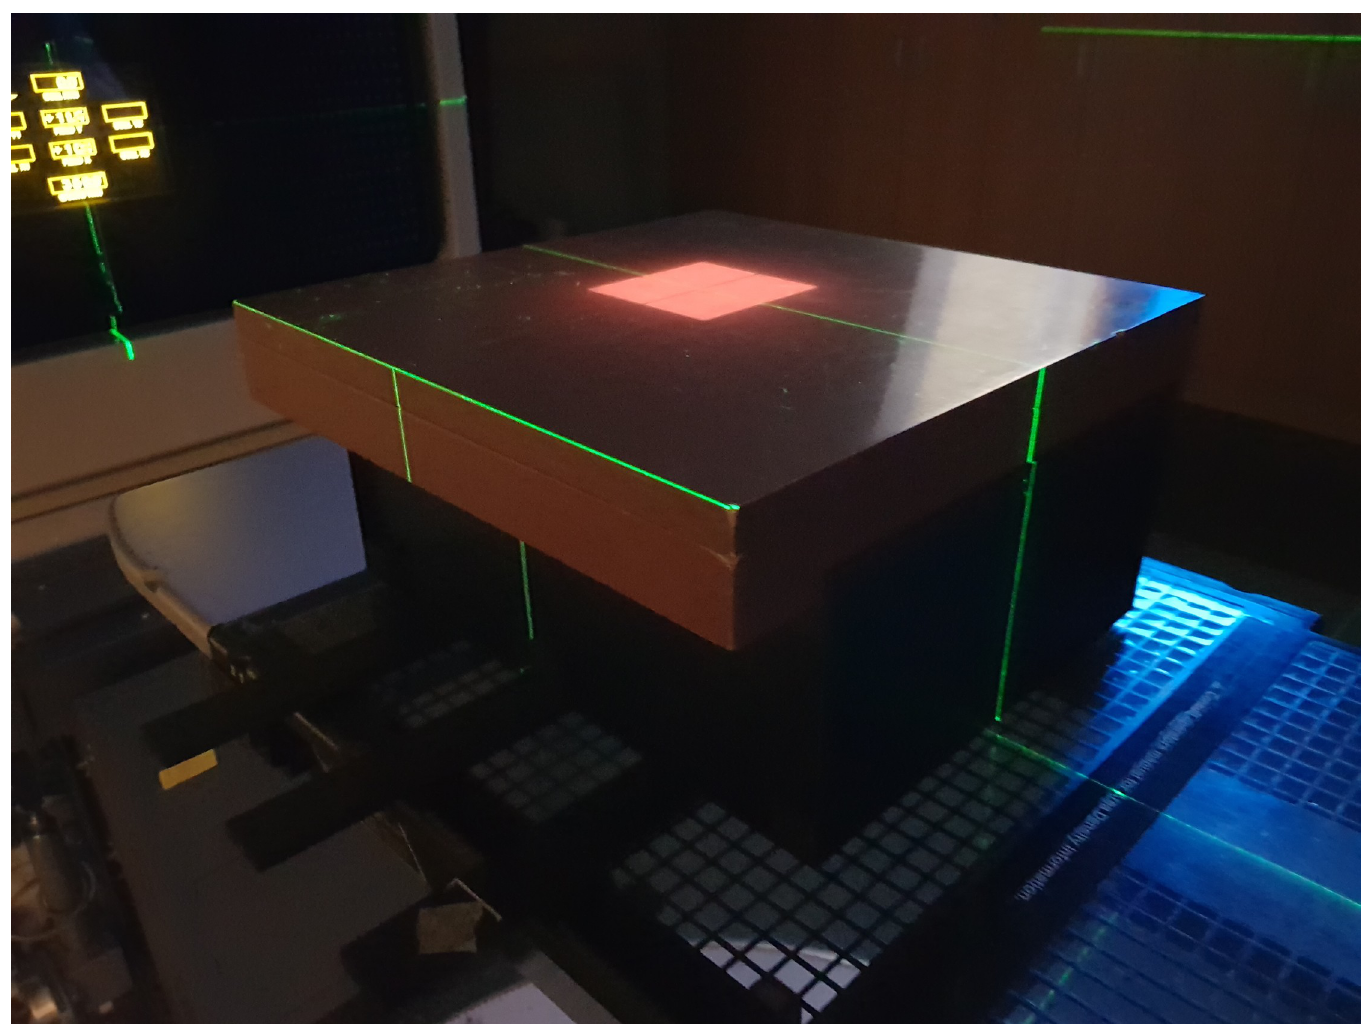
Fig 6. Image of the solid water phantom, 5.0 cm above the prototype of the TRMLSD with a 10.0 × 10.0 cm 2